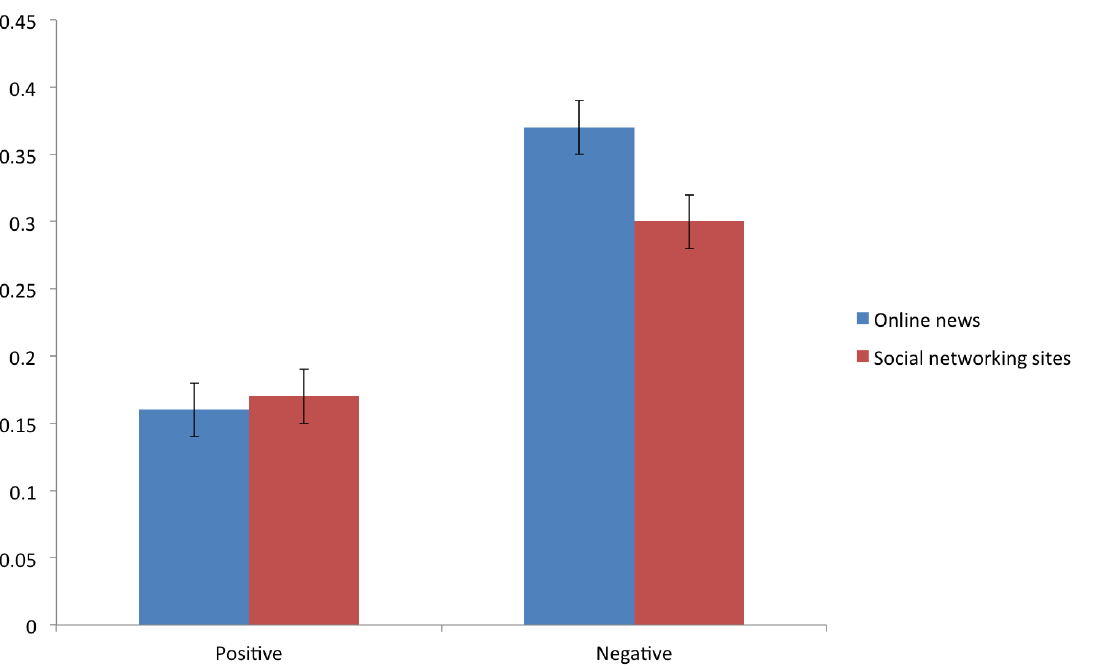
Figure 2: Effects of valence and source type on judged potential for change of